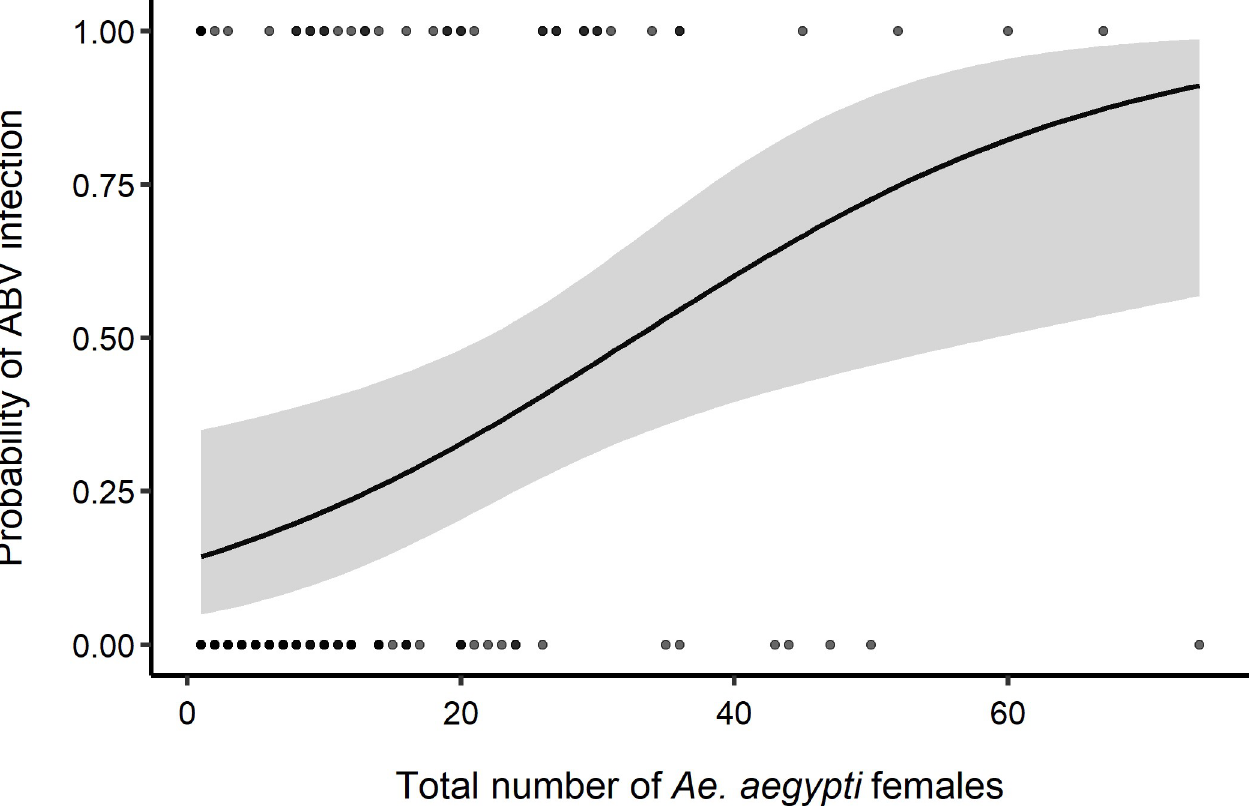
Fig 3. Predicted probability of ABV infection in female Ae . aeypti . Probability of detecting an infected female Ae . aegypti (0, uninfected, 1, infected) as a function of the total Ae . aegypti catch per house with evidence of recent arbovirus human infection, estimated from collections conducted during the ABV transmission seasons of 2016 and 2017 in Yucata´n, Mexico. Solid line represents the mean prediction from a binomial generalized linear mixed effects model and gray band the 95% CI of the prediction, dots indicate the binomial data, with dark dots showing the occurrence of multiple (overlapping) observations.